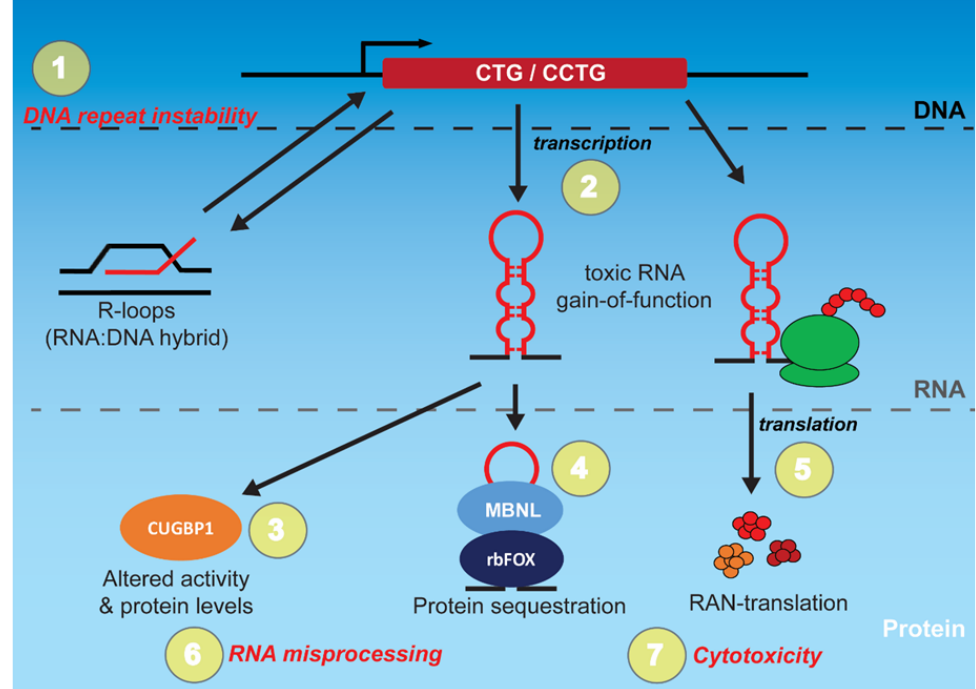
Figure 1. Multiple levels of disease mechanism and therapeutic targets in myotonic dystrophy (DM). A simplified schematic with both RNA gain-of-function (GOF) and repeat-associated non-ATG (RAN) translation protein products is illustrated. The specific proteins and processes vary between sense and antisense transcripts and between myotonic dystrophy type 1 (DM1) and 2 (DM2), with a generic process shown for review processes. Repeat expansion in the DNA is the source of numerous downstream pathogenic processes. Bi-directional transcription of CTG and CCTG repeat expansions produce toxic sense (CUG / CCUG) and antisense (CAG / CAGG) expansion RNA that can fold into hairpin structures with pathogenic downstream consequences. Co-transcriptional R-loops (a type of RNA:DNA hybrid) can trigger DNA repeat instability [1–3] which is positively correlated with increased disease severity. Toxic expansion RNAs can sequester important proteins, such as the MBNL and rbFOX family members [4], and trigger hyperphosphorylation of CUGBP1 leading to its increased steady state levels and altered activity. Toxic sense and antisense RNA can also trigger repeat-associated non-ATG (RAN) translation in multiple reading frames, producing toxic aggregating peptides that lead to cytotoxicity. Each of these di ff erent stages (expansion DNA, RNA, and protein) and their associated defects ( 1–7 ) represent a potential target of small molecules with unique advantages and disadvantages.